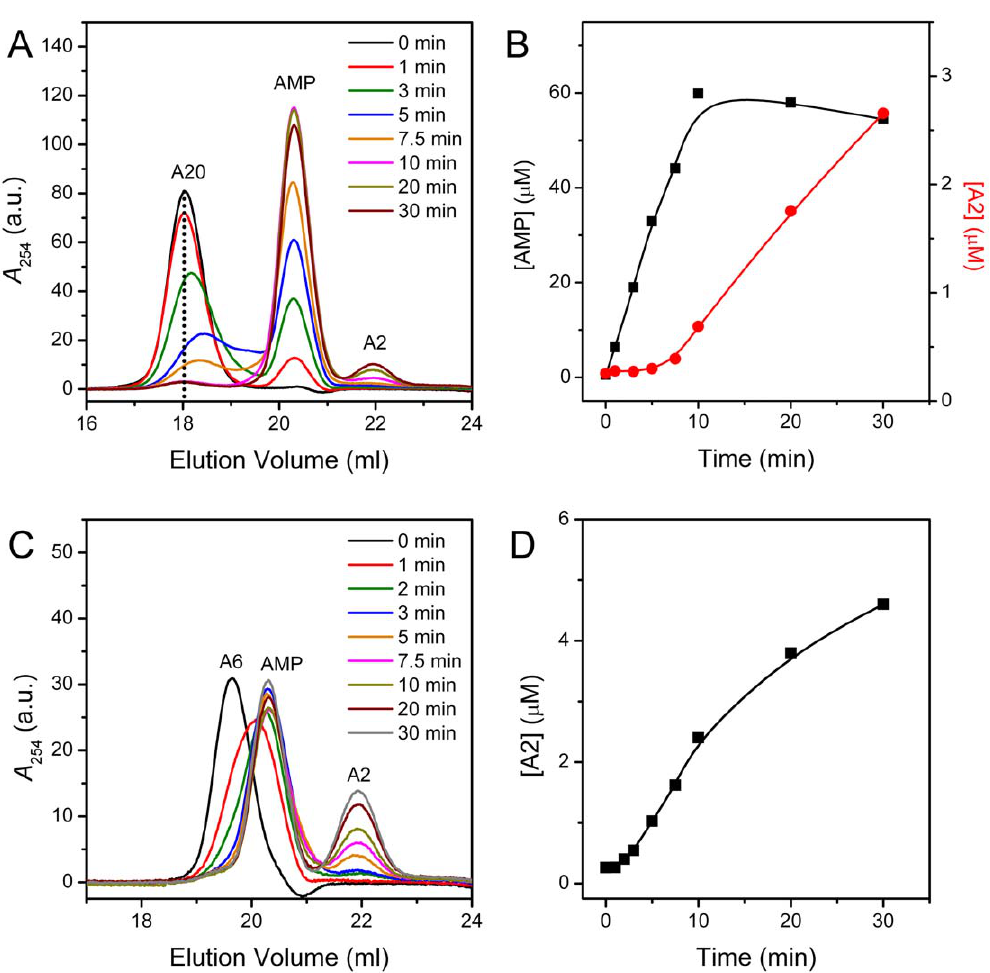
Figure 6. Characterization of the pattern of deadenylation by the SEC assay. (A) SEC elution profiles of the reaction solutions quenched at different time when using 5 m M A20 as the substrate. (B) Kinetics of AMP and A2 generation during A20 degraded by PARN. The concentration of A2 was calculated from the peak area using the standard curve obtained similar to that of AMP shown in Figure 1C. (C) SEC elution profiles of the reaction solutions using 5 m M A6 as the substrate. (D) Kinetics of A2 generation during A6 degraded by PARN. The curve of AMP generation could not be accurately obtained due to the overlapping of the elution peaks from A6 and AMP.